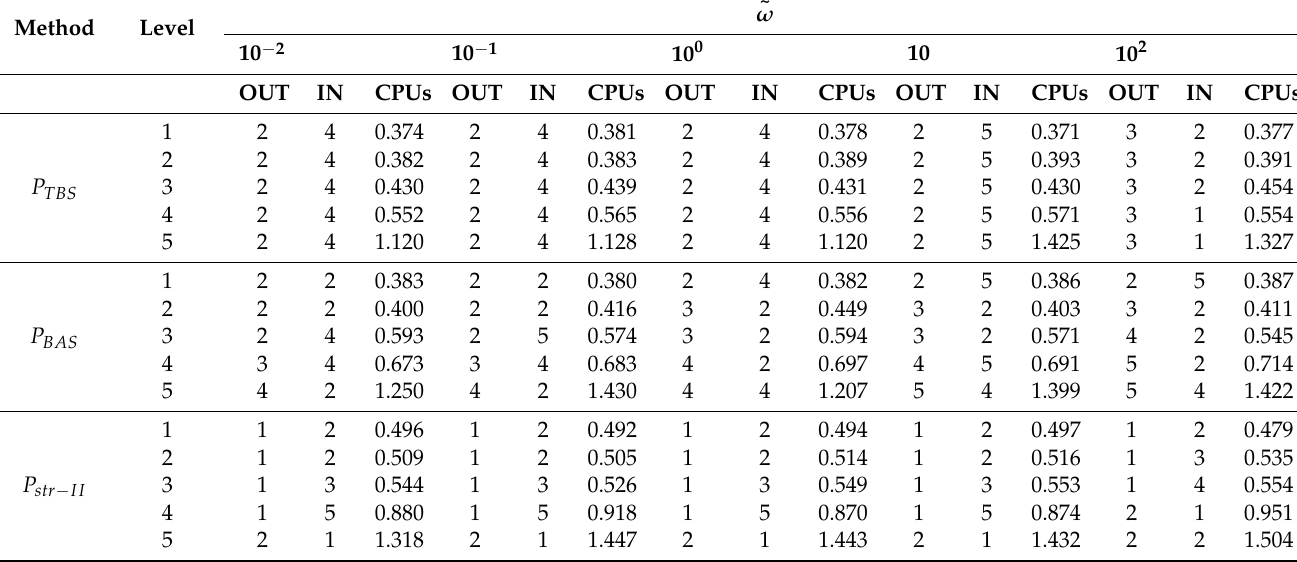
Table 9. Different mesh refinement levels and (cid:101) ω , the result of the preconditioned GMRES (5) in the 2D case, with ε = 10 − 2 . Method